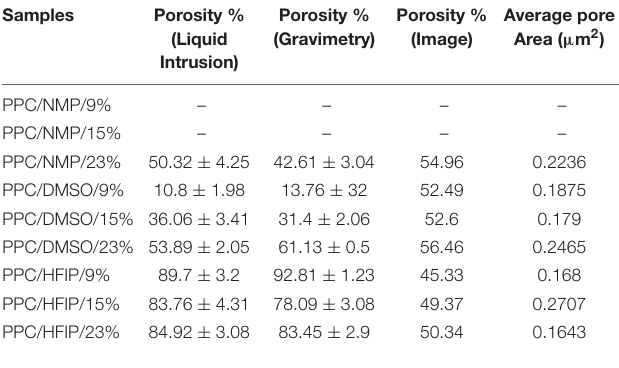
TABLE 2 | Porosity and average pore area of electrospun nanofibers.